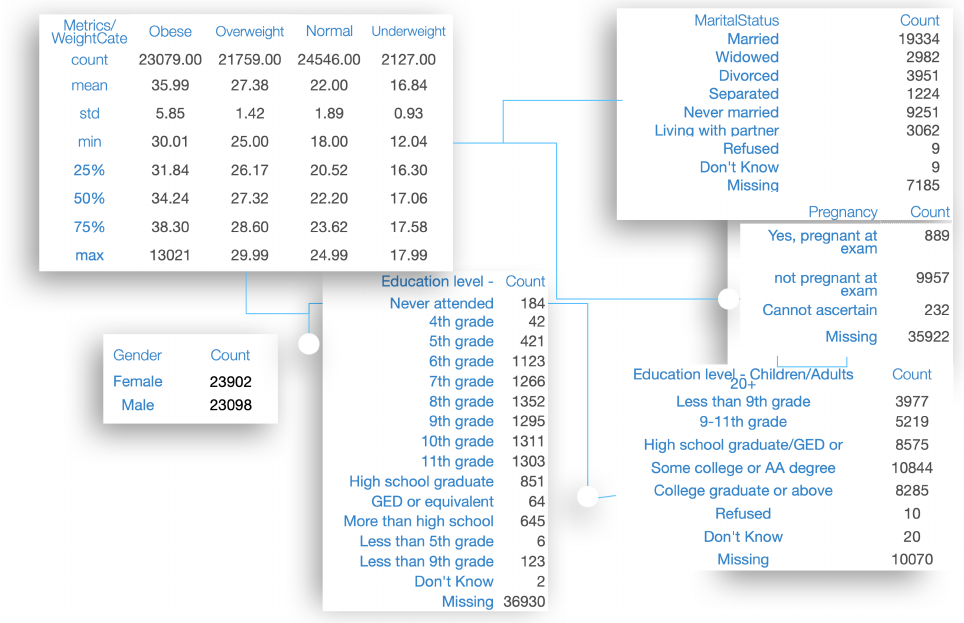
Figure 6. Descriptive analysis of data and selected